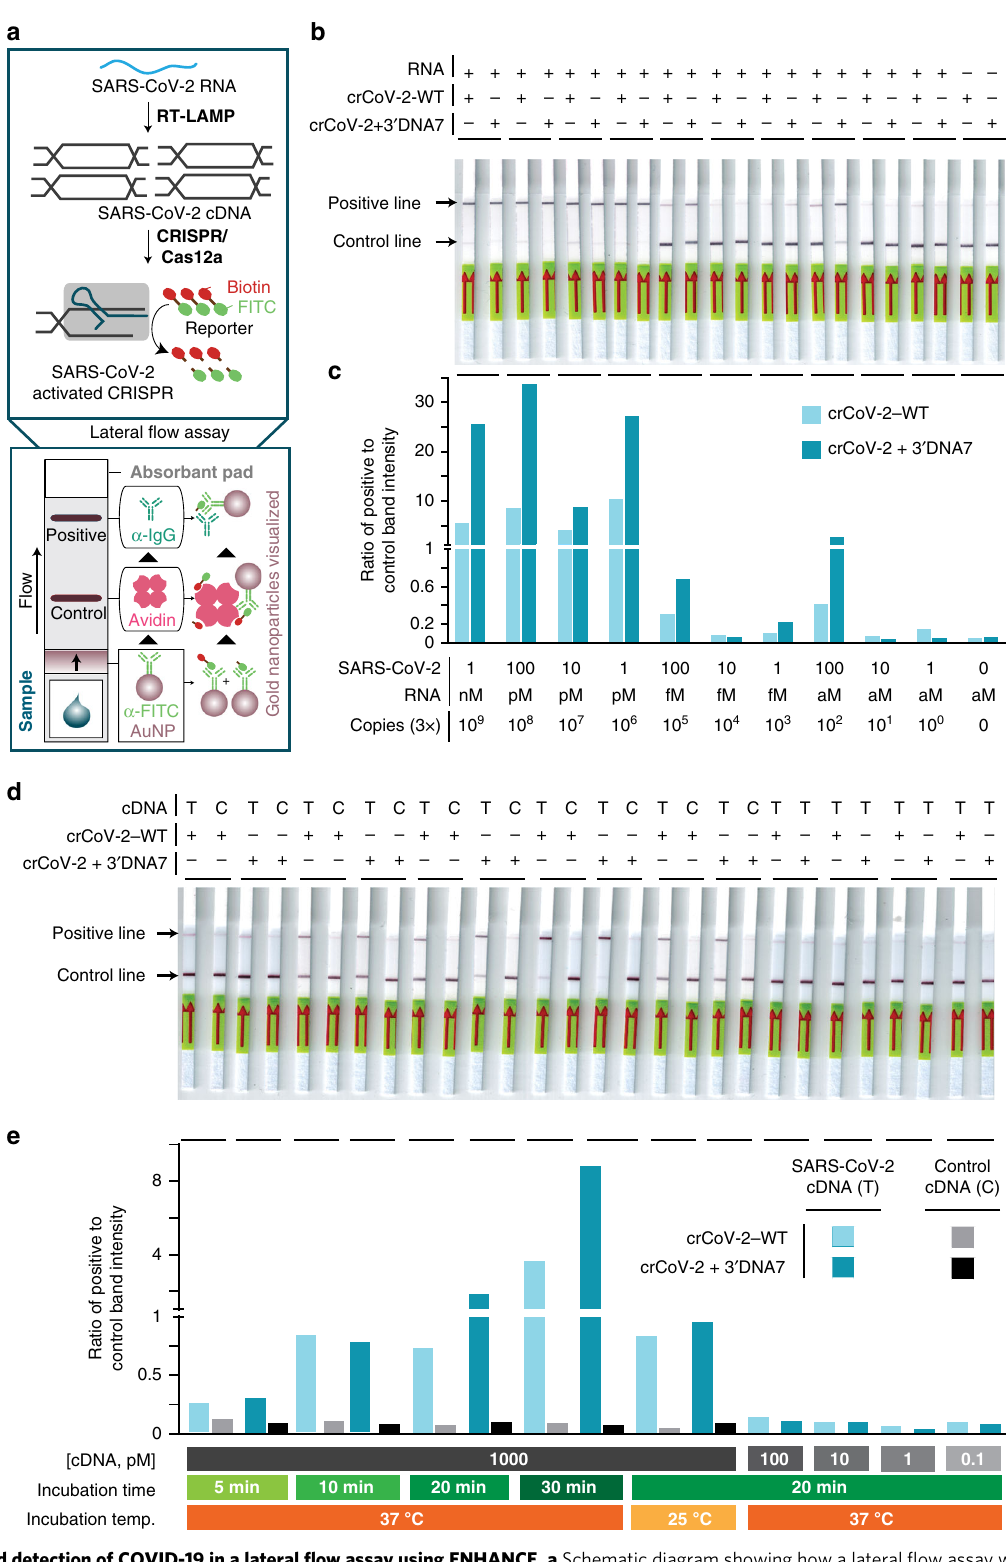
Fig. 6 Improved detection of COVID-19 in a lateral fl ow assay using ENHANCE. a Schematic diagram showing how a lateral fl ow assay works. Brie fl y, the dipstick uses gold-labeled FITC-speci fi c antibodies that bind to FITC-biotin reporters and travel through the membrane. Only the cleaved reporters will reside at the positive line. b Lateral fl ow assay detecting SARS-CoV-2 RNA N gene using crCov-2 and crCoV-2 + 3 ′ DNA7 with RT-LAMP, and c band- intensity analysis of b using ImageJ. d Lateral fl ow assay detecting SARS-CoV-2 cDNA using crCov-2 and crCoV2 + 3 ′ DNA7 without a pre-ampli fi cation step, and e band-intensity analysis of d using ImageJ. Source data are available in the Source Data fi